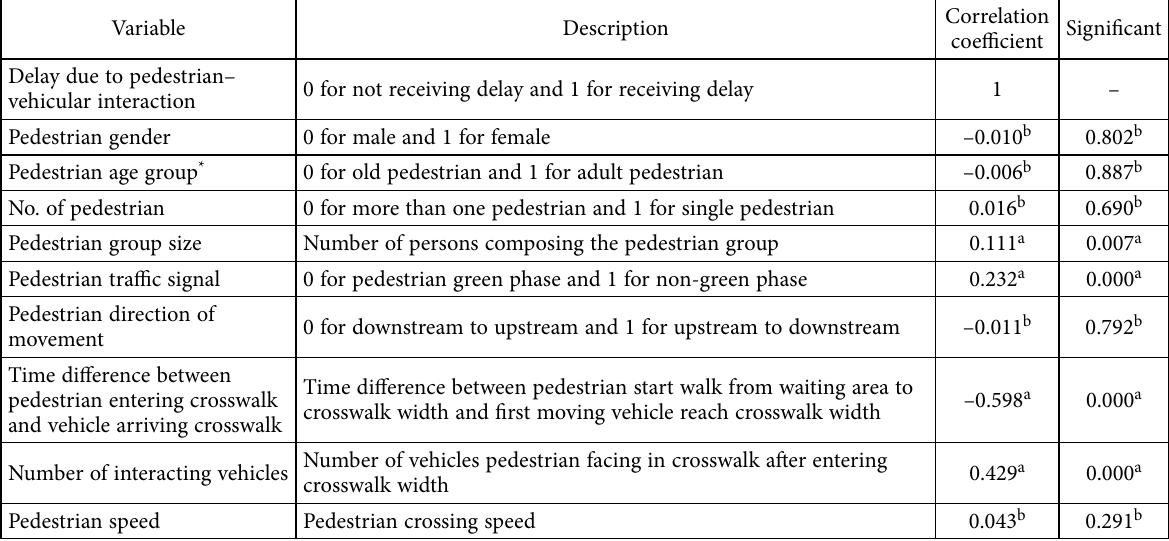
Table 3. List of parameters of pedestrian–vehicular interaction behaviour and results of Pearson’s correlation analysis